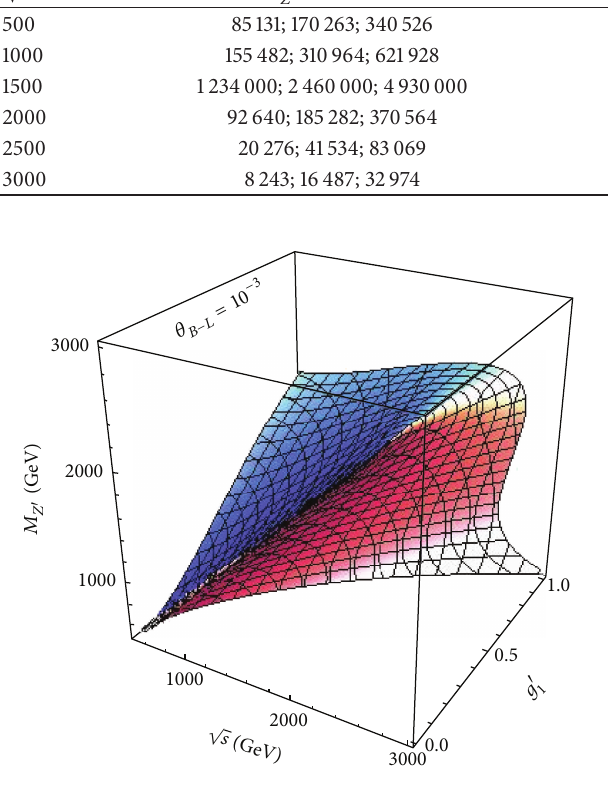
Figure 10: Contour plot 3D for the total cross section 𝜎 tot = (√𝑠, 𝑀 , 𝑔 󸀠 ) of the process 𝑒 + 𝑒 − → 𝑍ℎ for 𝑀 𝜎 tot 𝑍 󸀠 1 = 10 − 3 𝜃 𝐵−𝐿